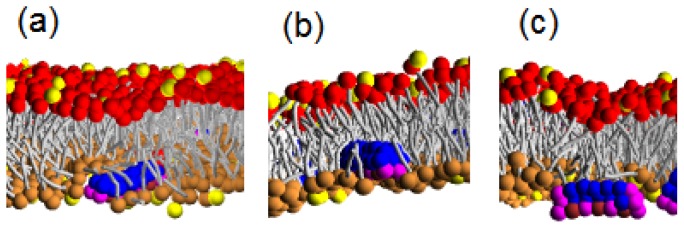
The penetration depth of (a) Pep-I; (b) Pep-II and (c) Pep-III into the D-lipid bilayer in the binding state simulated at aPhC = 50.